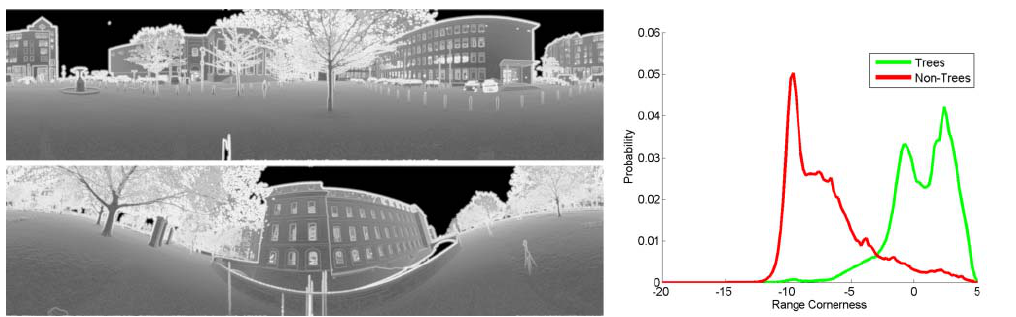
Figure 4. Cornerness values of the range channel and their tree/non-tree distribution.